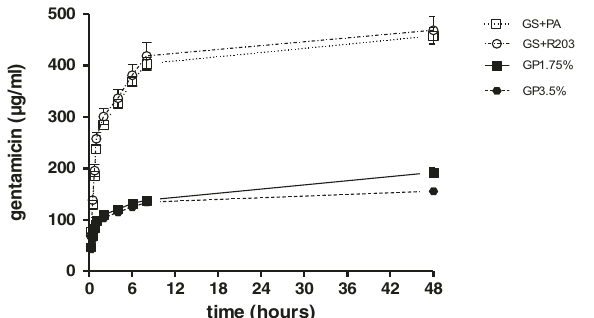
Fig. 4 SA growth inhibition in bacterial suspension with circular probes of untreated, non-gentamicin, and gentamicin-coated ePTFE grafts